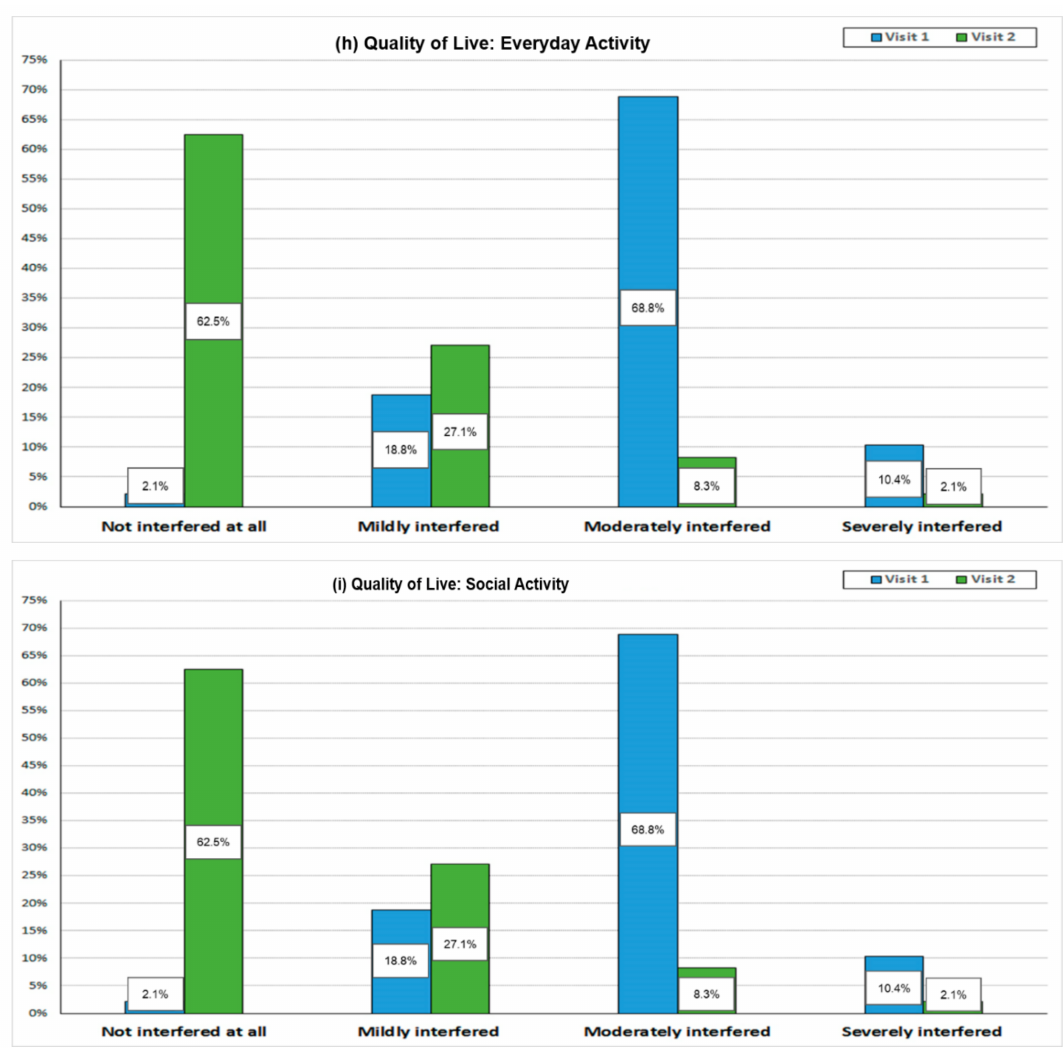
Figure 1. Distribution of scores at visit 1 and follow-up svisit in 48 female patients with AC. ( a ) Frequency; ( b )Urgency; ( c ) Painful urination; ( d ) Incomplete bladder emptying; ( e ) Discomfort lower abdomen; ( f ) Blood in urine; ( g ) Quality of Life: General Discomfort; ( h ) Quality of Live: Everyday Activity; ( i ) Quality of Live: Social